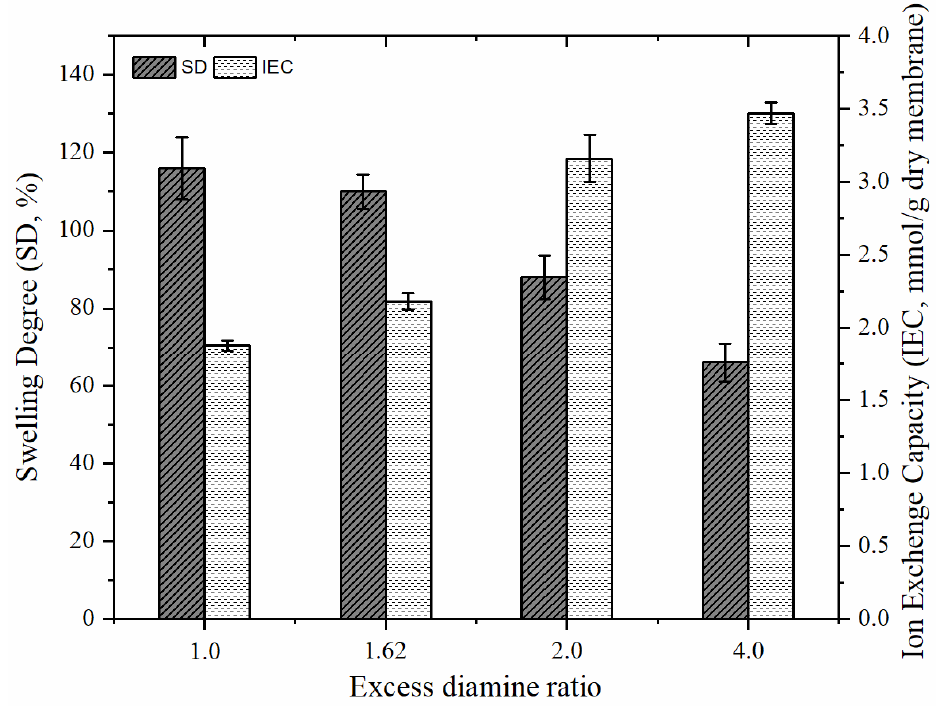
Figure 7. The effect of excess diamine ratio on SD and IEC of synthesized AEMs (BR:1.07).